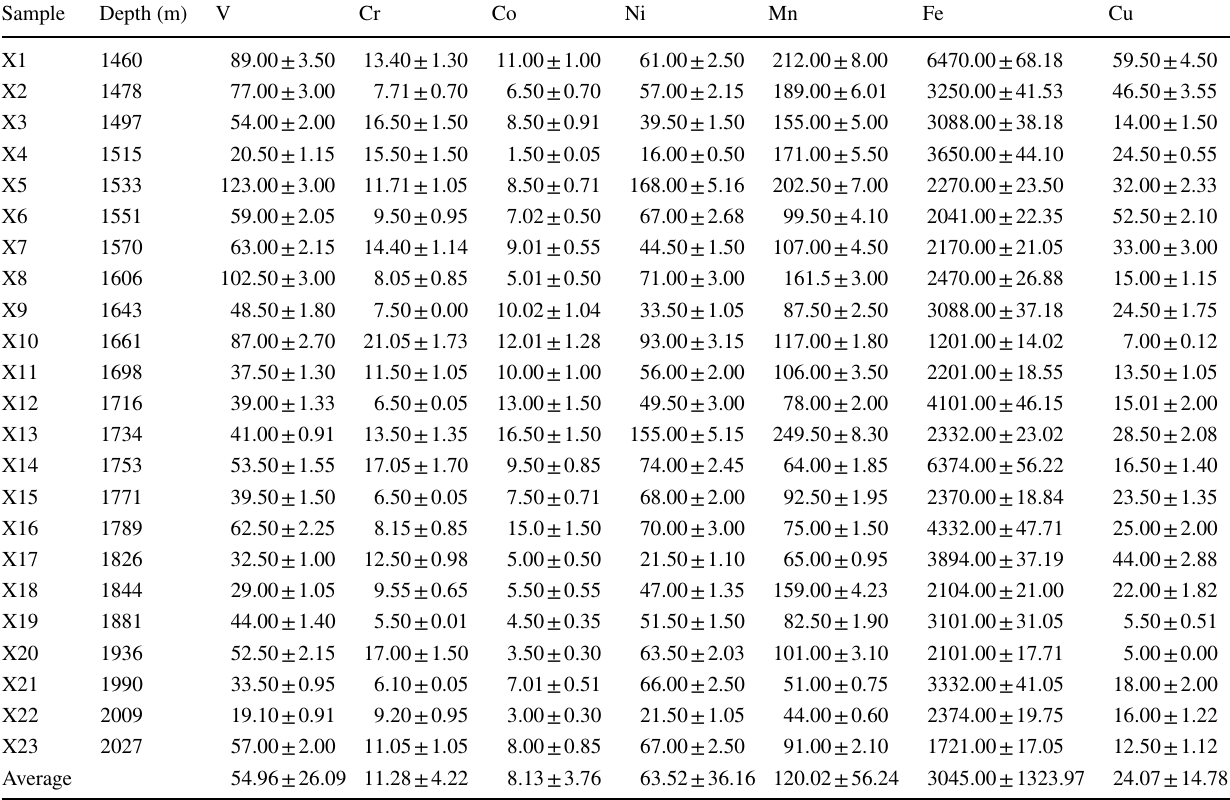
Table 1 Trace elements composition (in ppm) of kerogens from Well X in the central Niger